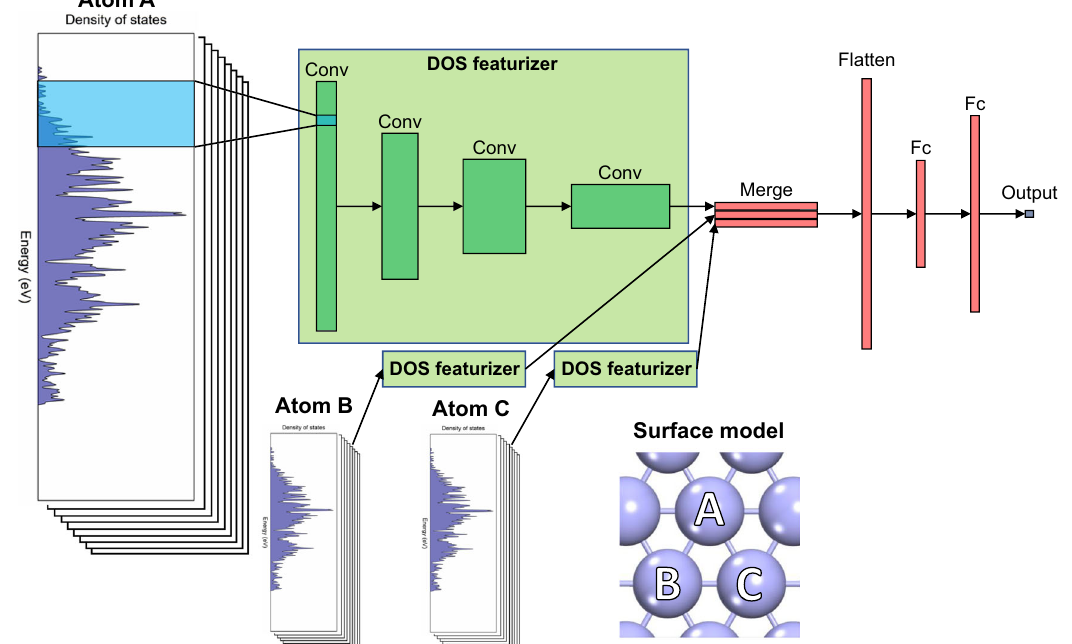
Fig. 1 General schematic of the DOSnet model. The site-projected DOS of a surface atom serves as the input (light blue) which goes through a series of convolutional layers (green), followed by fully connected layers (red) and a fi nal output layer. For additional atoms, the same convolutional layers are used with shared weights before being merged with the fully connected